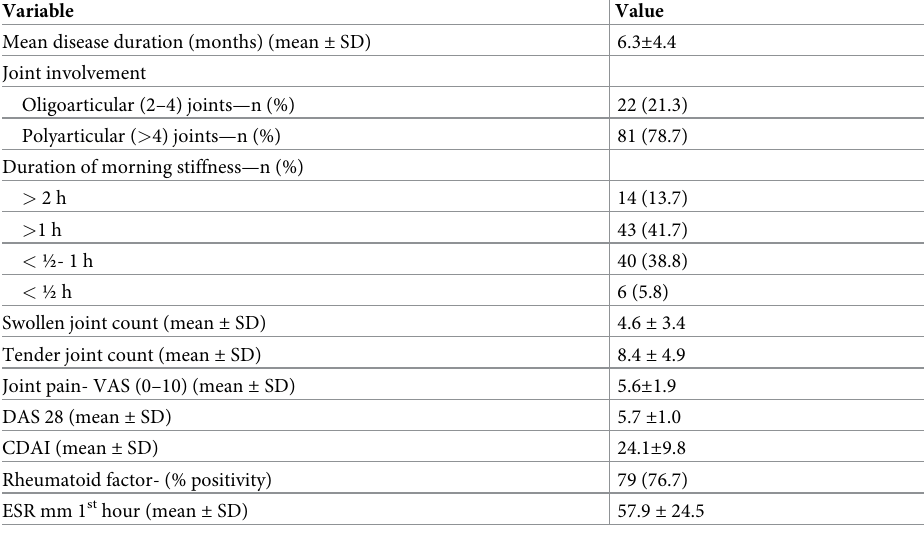
Table 2. Disease characteristics of RA patient at their initial presentation.